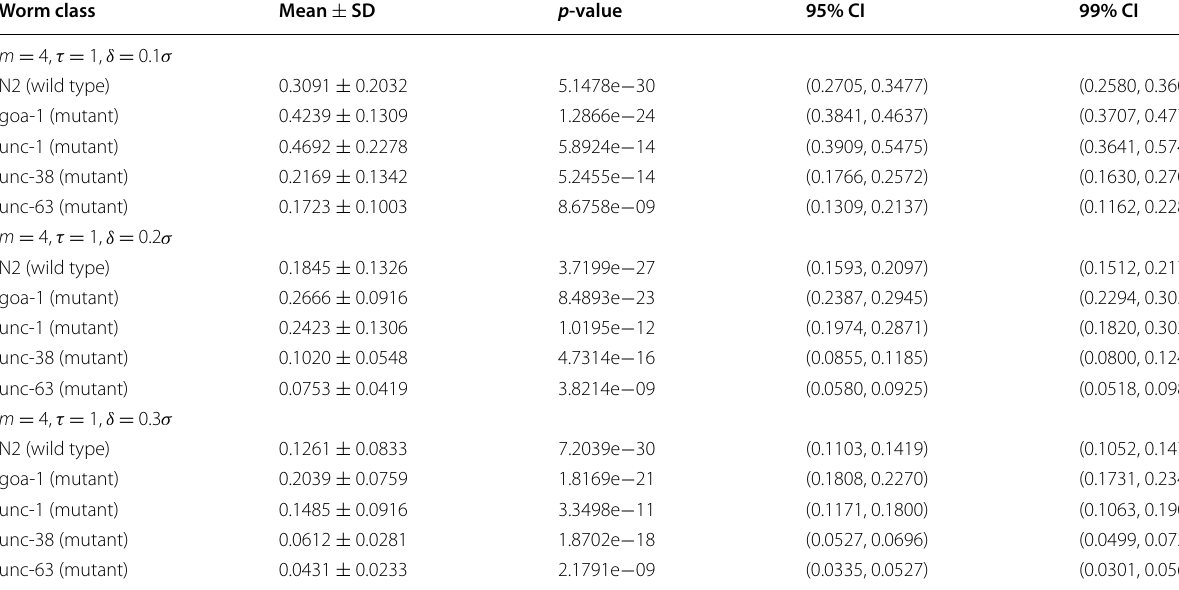
Table 4 Average SampEn values and confidence intervals of eigenworm recurrence behavior Worm class Mean ±